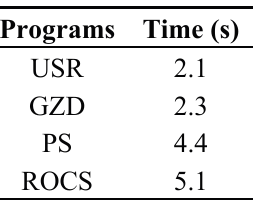
Table 6. Computational time for calculating similarity between 850 compounds and a template